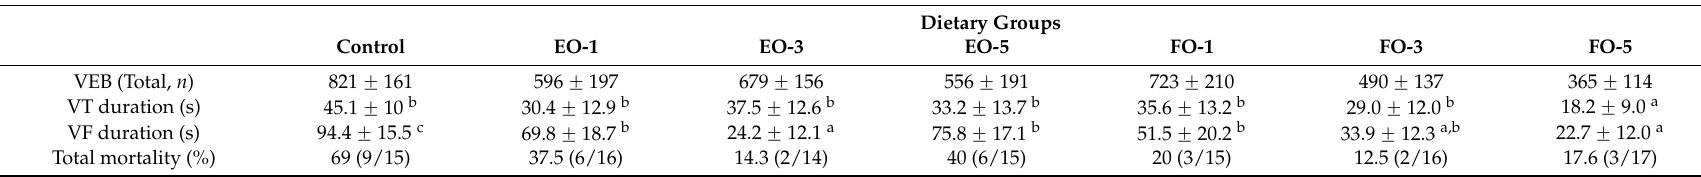
Table 6. The effects of oil type and dose on parameters of cardiac arrhythmia in Sprague Dawley rats fed diets supplemented with Echium oil (EO) or fish oil (FO) following coronary artery